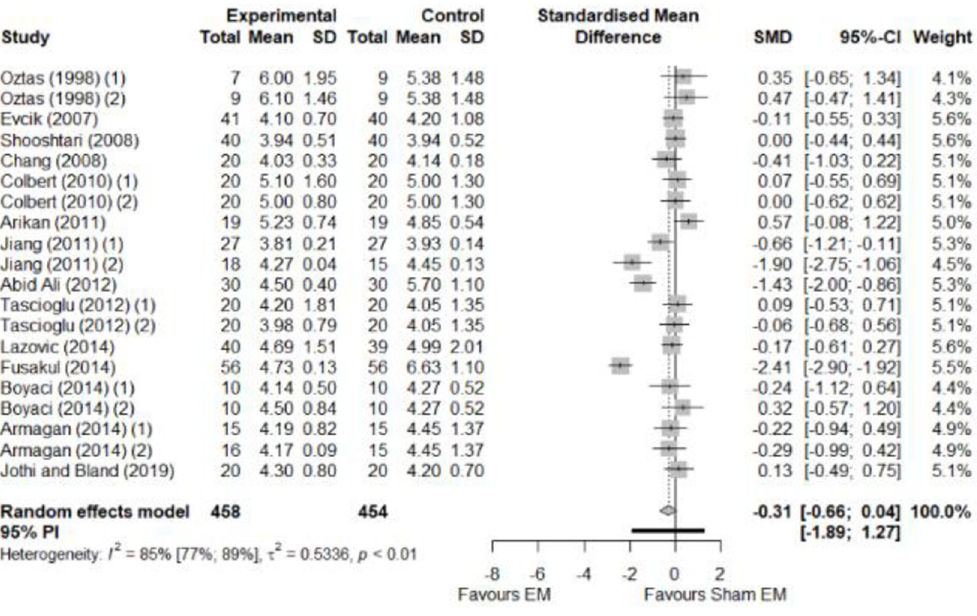
Fig 6. Analysis—Electrophysical modalities versus placebo (motor latency). Studies with more than two intervention groups (different modalities, treatment doses, or symptom classification) were numbered as (1) and (2).